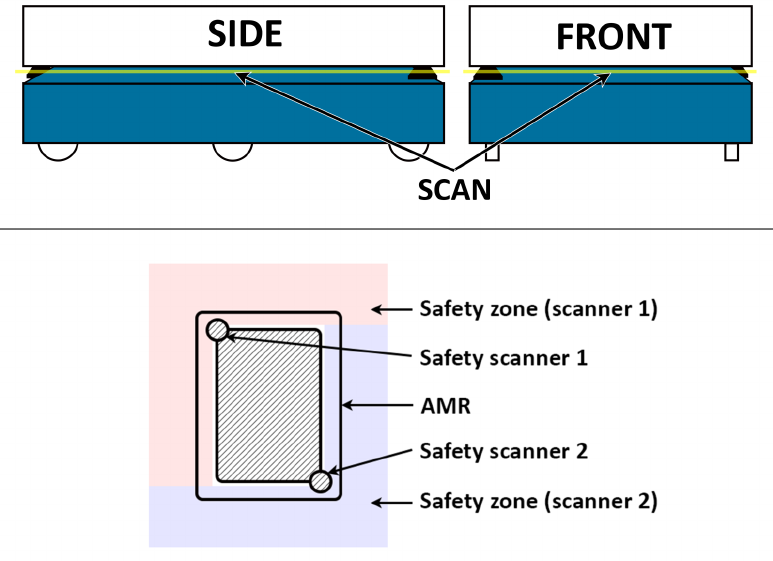
Figure 5. The measuring slot and placement of safety zone